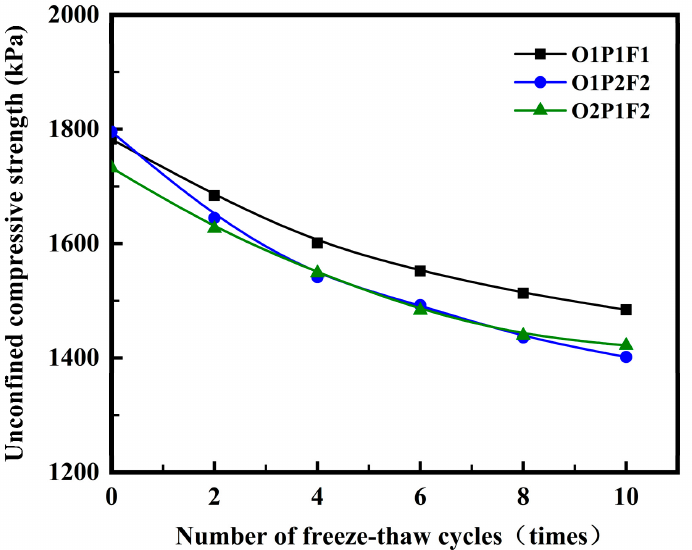
Figure 5. Unconfined compressive strength of specimens under freeze-thaw